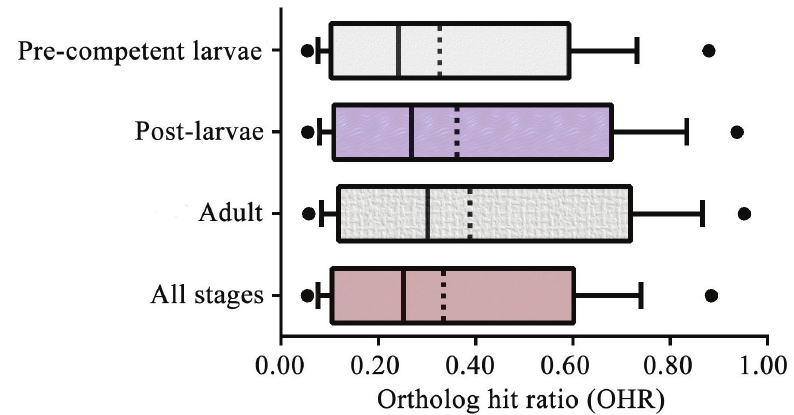
Figure 3. Assessing the coverage of the transcriptomes for the four life cycle/all stages with ortholog hit ratio (OHR). The boxes, error bars, and solid dots demarcate the 25th and 75th, 10th and 90th, and 5th and 95th percentiles, respectively, of the OHRs for all contigs of an assembly with a significant BLAST hit. In turn, the broken and solid lines of each box mark the mean and median OHRs,